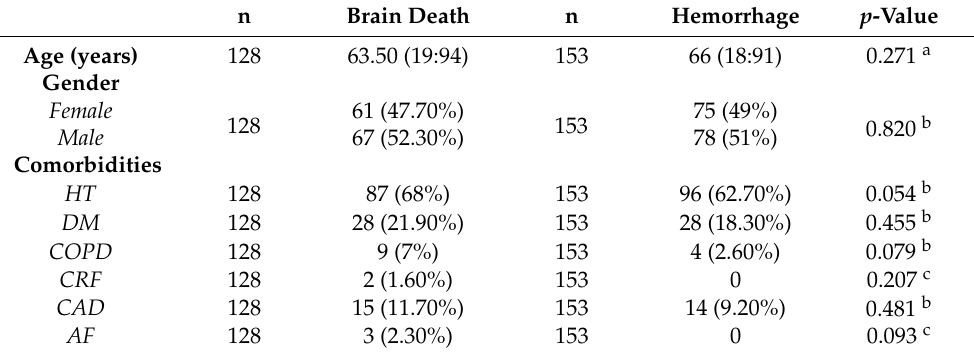
Table 1. Demographic characteristics and comorbidities.